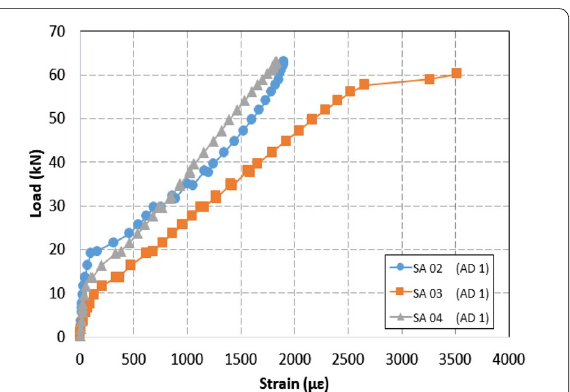
Fig. 8 AD steel load–strain curve.